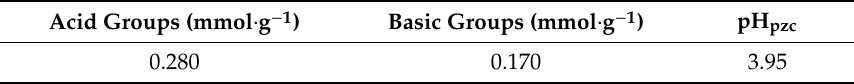
Table 5. Zero charge potential (pHpzc) results and bioadsorbent active sites.